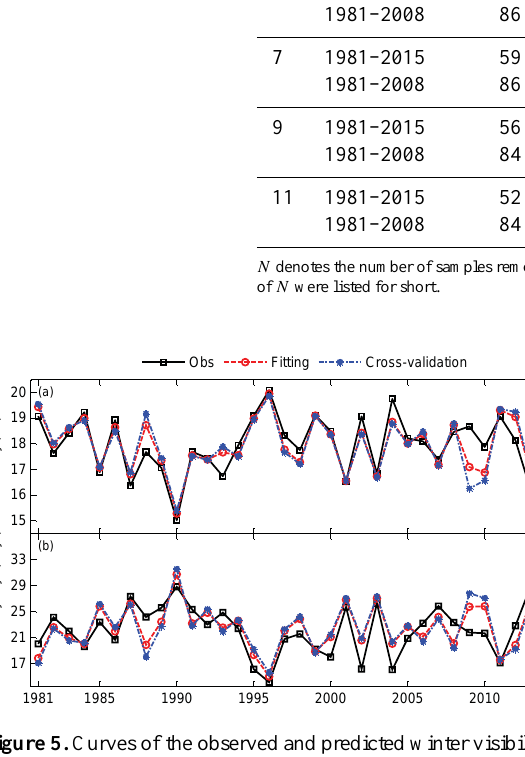
Figure 5. Curves of the observed and predicted winter visibility (a) and number of hazy days (b) in the BTH region since